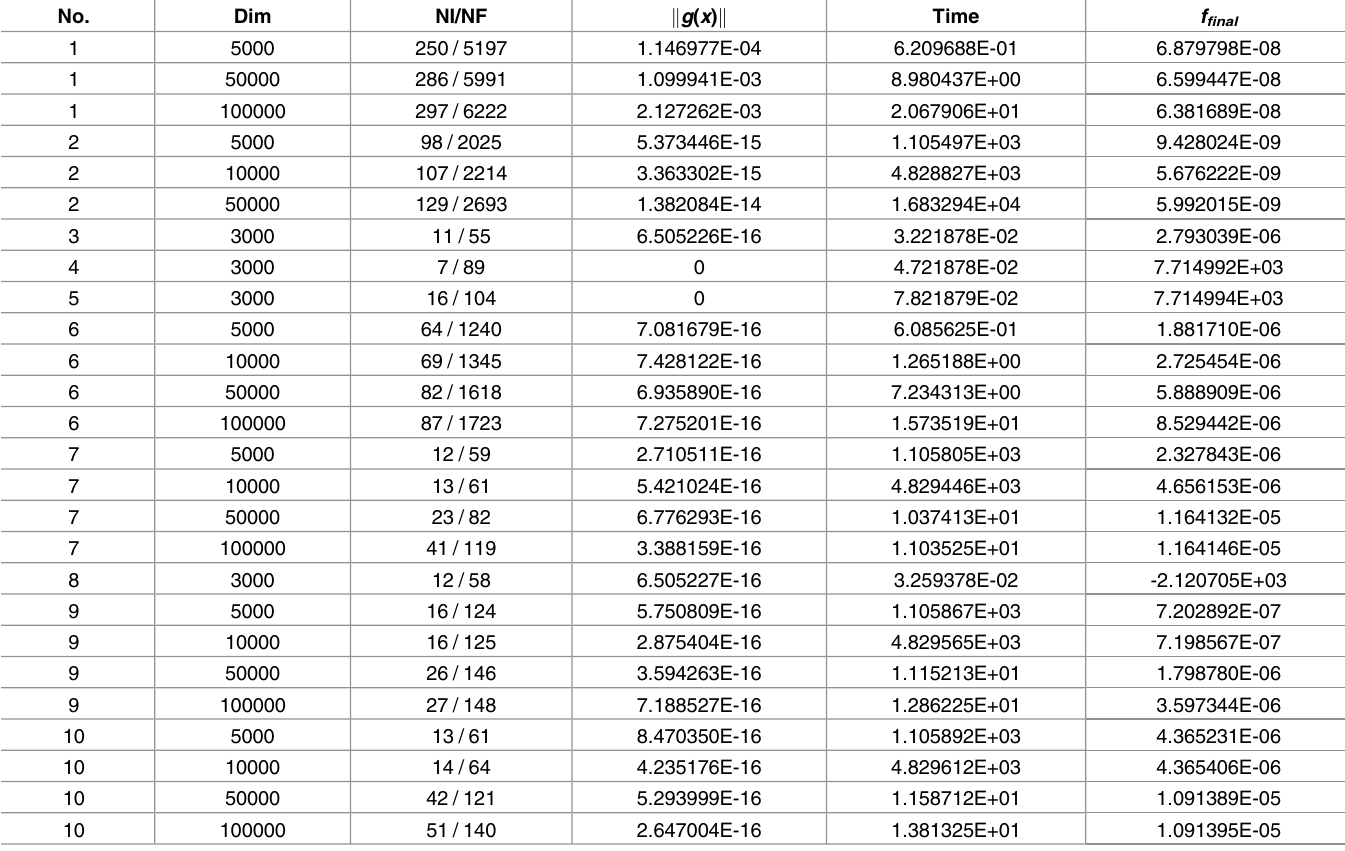
Table 4. Test results for